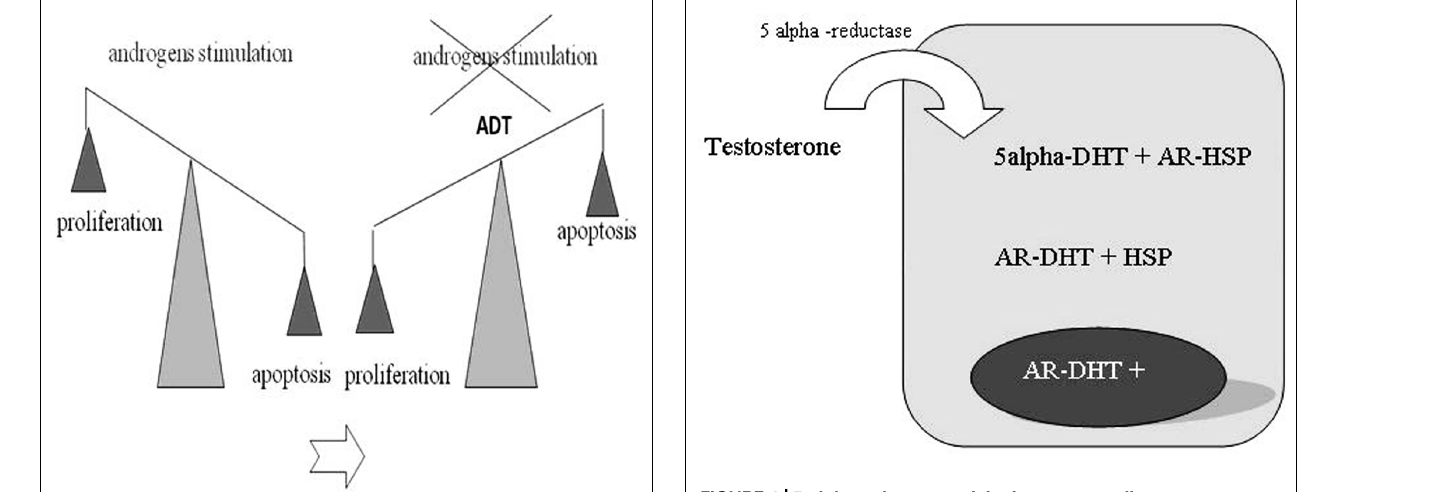
FIGURE 4 | 5-alpha-reductase activity in prostate cells.